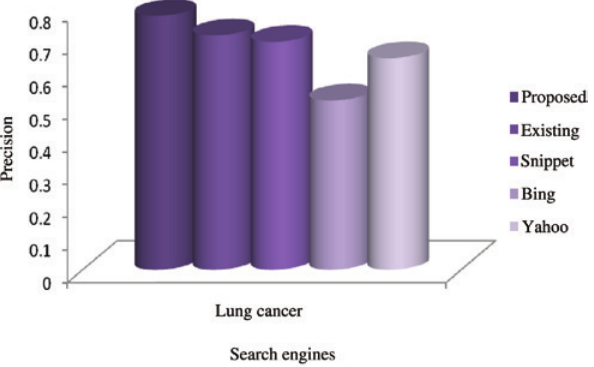
Figure 3: Precision Comparison for the User-Given Query “Lung Cancer” When Topmost Links Are Taken.